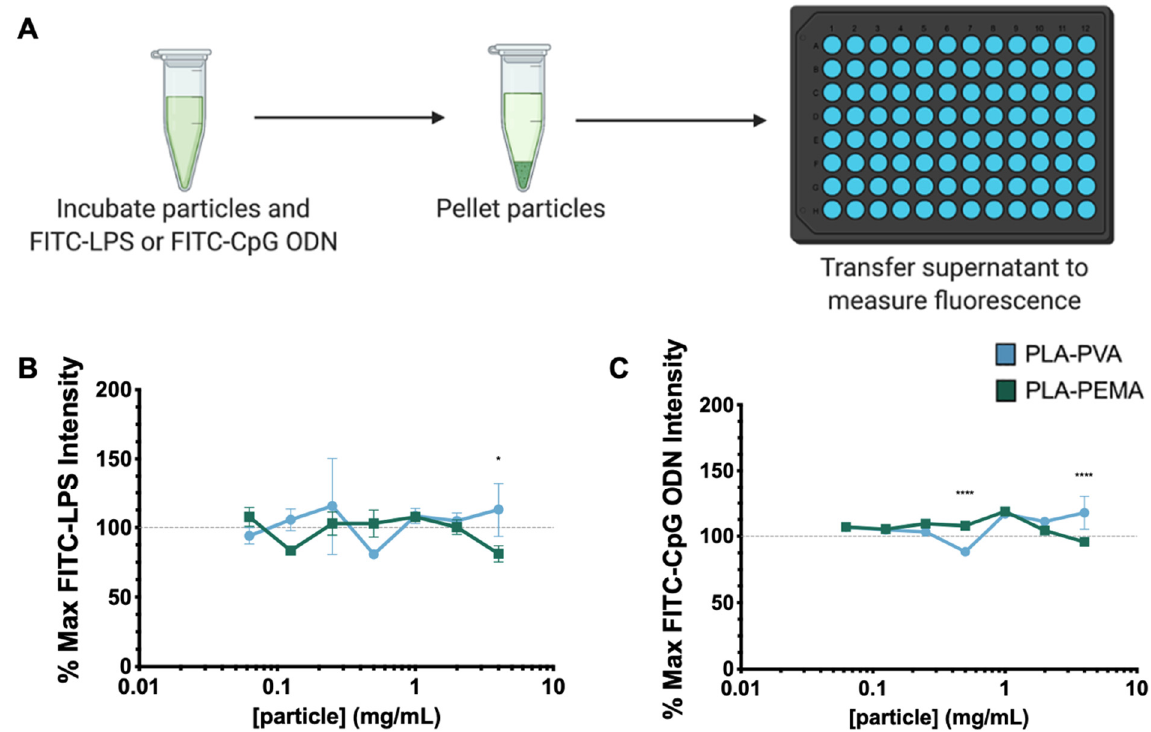
Figure 2. Under typical in vitro serum conditions, both particle types fail to sequester FITC-tagged TLR agonists. ( A ) Particles and FITC-conjugated TLR agonists were co-incubated at 37 °C and 5% CO2 for 1 h and then pelleted to determine direct interactions between particles and TLR agonists. When co-incubated with PBS containing 10% FBS, both ( B ) FITC-LPS and ( C ) FITC-CpG ODN fail to interact with particles alone as signified by the dashed line representing 100% FITC signal of FITC-LPS ( B ) or FITC-CpG ODN ( C ) alone. Schematic in ( A ) created with BioRender. Statistical differences between groups were determined by performing Student’s t -test. Error bars represent SD. * for p ≤ 0.05 and **** for p ≤ 0.0001.